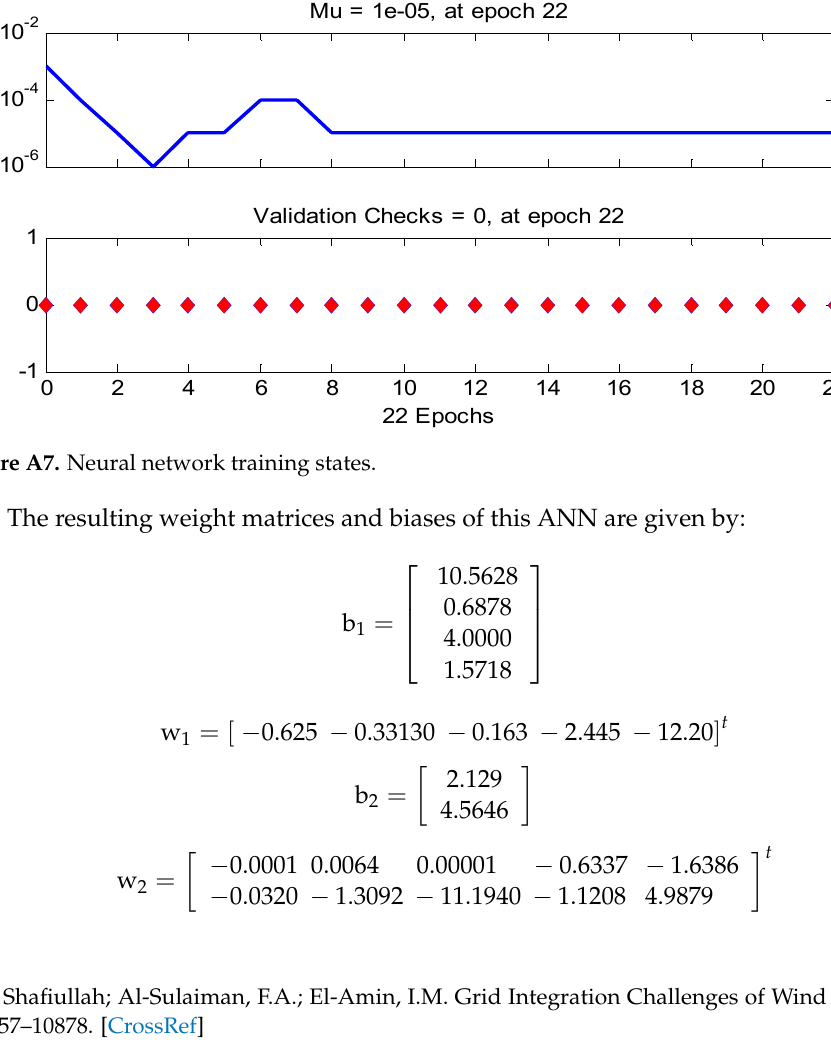
23 of 25 Figure A5. Structure of the ANN for the LMPC-ANN controller. Table A1. Structure of the ANN. Construction Discerption w1 hidden and input neurons weight b1 hidden nodes biases hidden layer output oh = tansig (w1*in, b11) w2 Hidden and output weights b2 output nodes biases The output of ANN o1 = purelin (w2*oh, b2) Parameters Computation for for The LMPC-ANN Controller The training data was fed to Matlab Toolbox to calculate the weights and biases of artificial neural network. The statistical data for artificial neural network training: No of iterations = 1000 Max. Squared error = 1 × 10 − 7 Learning rate = 0.001